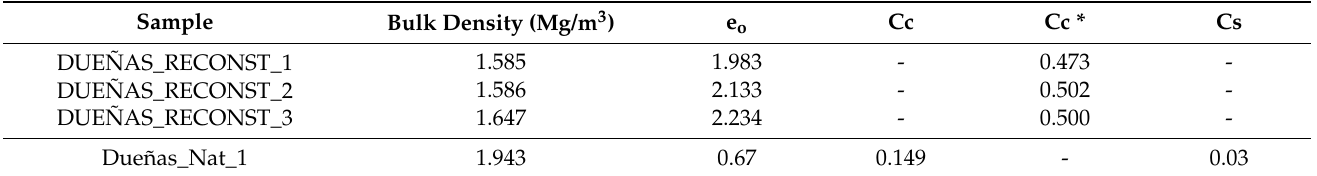
Table 5. Compression characteristics as determined by the oedometer tests using natural and reconstituted samples. (e o ), initial void ratio; (Cc), compression index; (Cs), swelling index; (*), intrinsic properties. Sample Bulk Density (Mg/m 3